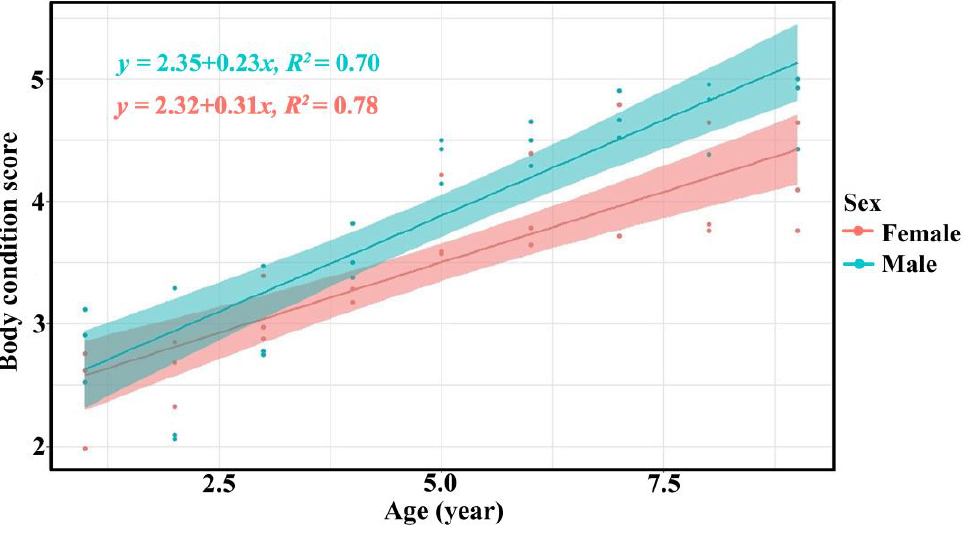
Figure 3. Relationship between age and weight of ( a ) male and ( b ) female captive banteng by re- searchers.